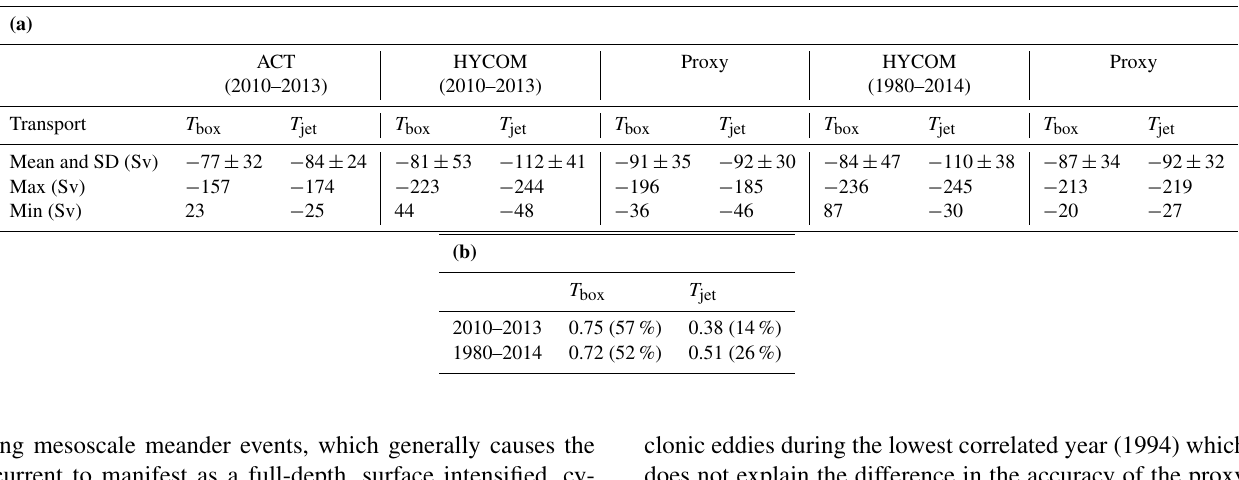
Table 2. (a) Summary of the transport statistics of the ACT observations over the 3-year in situ period and the HYCOM model transports and HYCOM proxy transports over the 3-year and extended 34-year time periods. Negative values denote transport in the southwest